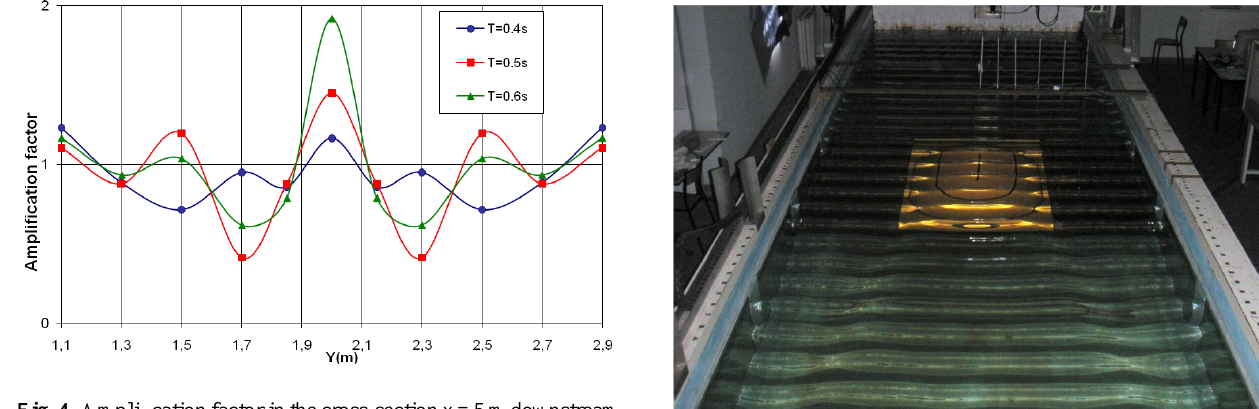
Fig. 4. Amplification factor in the cross-section x=5m downstream Fig. 4: Amplification factor in the cross-section x=5m downstream the shoal of the shoal. Table 3. Wave slopes along the y-axis. phase in the cross section, the maximum slope is given by  H/ L c where  H is the difference between the maximum (at Y= Y max =2) and the first minimum (at Y=Y min ) and L c = Y min - Y max . The RSW can be expressed as follow: